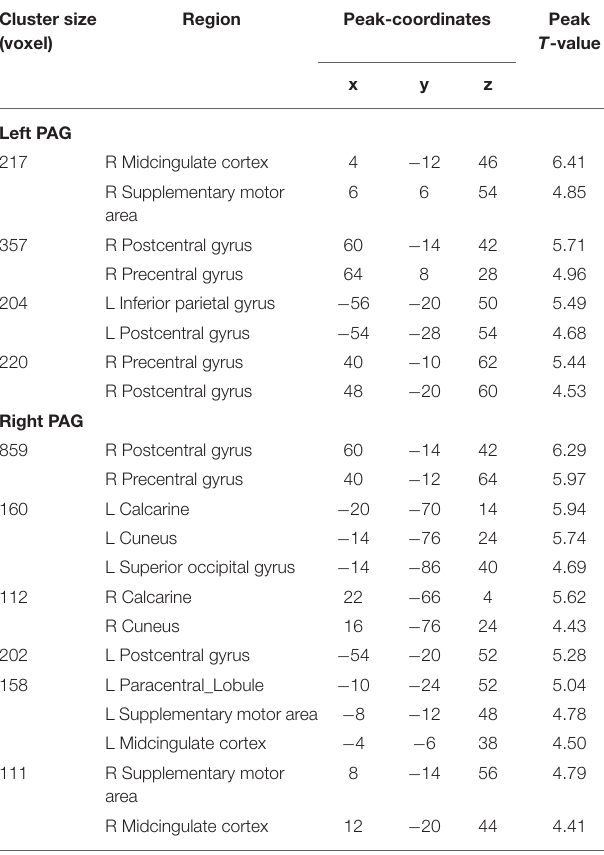
TABLE 3 | Associations of migraine frequency, migraine disability, and average pain intensity with